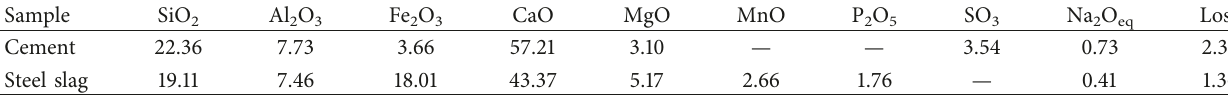
Table 1: Chemical compositions of the cement and steel slag (%).